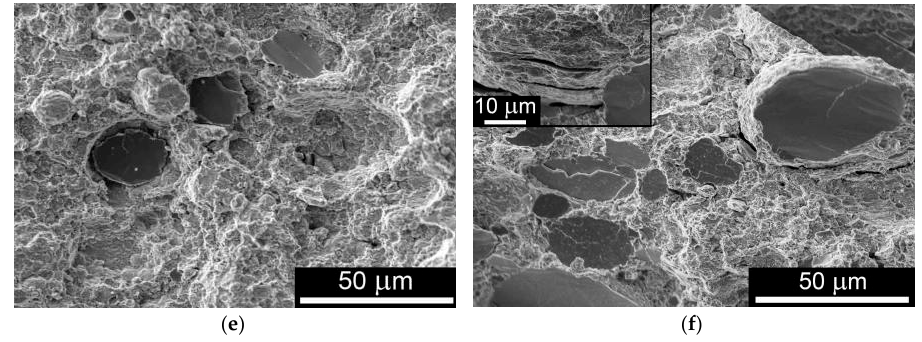
Figure 5. Microstructure of materials prepared from Zn7.5 powder, SEM : ( a ) 400 MPa, CP; ( b ) 500 MPa, CP; ( c ) 200 MPa, CP-S; ( d ) 500 MPa, CP-S; ( e ) 100 MPa, HP; ( f ) 500 MPa, HP.